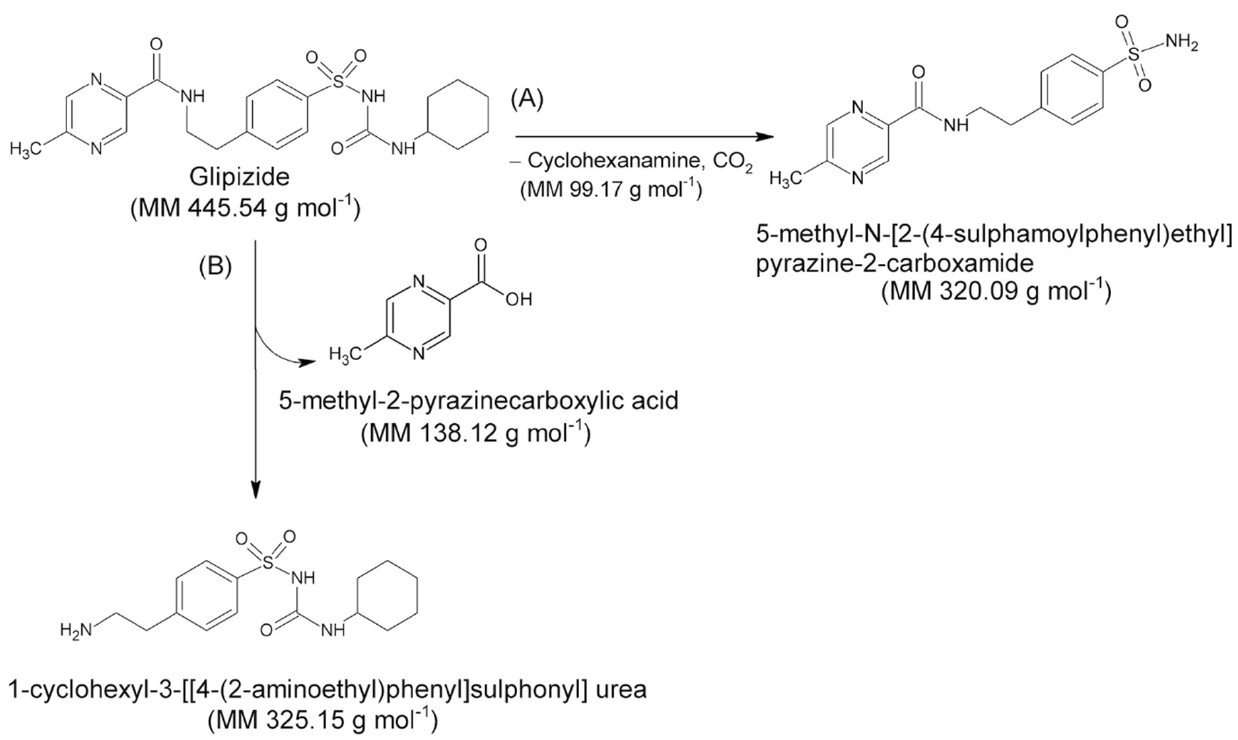
Figure 4. Decomposition reaction schemes hypothesized for the GPZ molecule. ( A ) Formation of 5-methyl- N -[2-(4- sulphamoylphenyl) ethyl] pyrazine-2-carboxamide; ( B ) Formation of 1-cyclohexyl-3-[[4-(2aminoethyl) phenyl] sulfonyl] urea.